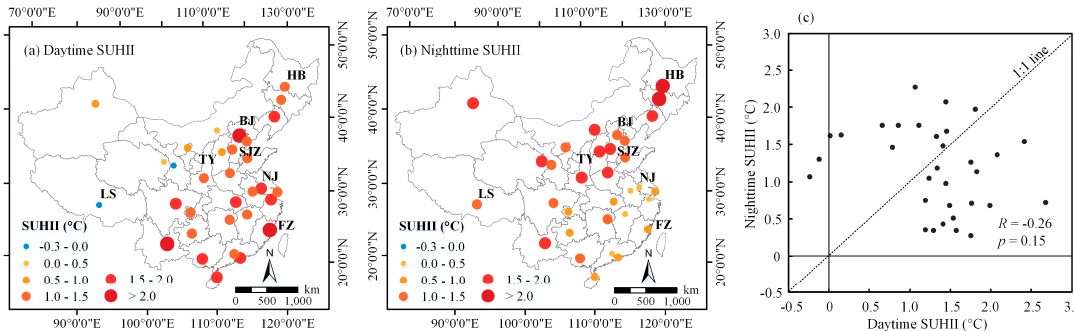
Figure 5. The spatial distribution of annual mean ( a ) daytime surface urban heat island intensity (SUHII) and ( b ) nighttime SUHII averaged over the period of 2008–2012 for the 32 major cities in mainland China; and ( c ) the scatterplot of daytime SUHII versus nighttime SUHII. R represents the correlation coefficient value, and p represents the degree of the significant correlation. (BJ: Beijing; FZ: Fuzhou; HB: Harbin; LS: Lhasa; NJ: Nanjing; SJZ: Shijiazhuang; TY: Taiyuan).